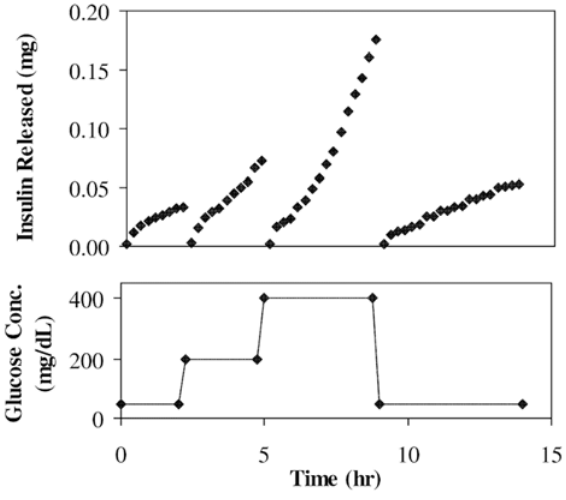
Figure 20. Profiles of insulin delivery across a membrane in response to glucose steps (50 to 200 to 400 to 50 mg/dL) in pH 7.4 PBS (10 mM/0.15 M NaCl) at 37 °C. The membrane consisted of 1.5 mg of GOD/0.43 mg of catalase and 35 wt % of the nanoparticles with a NIPAm:MAA molar ratio of 1:1. Reprinted with permission from [85]. Copyright 2002